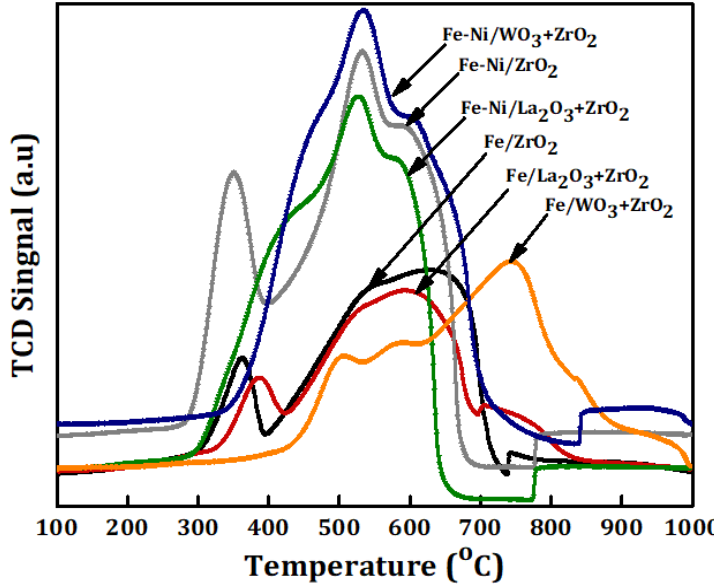
Figure 3. Temperature-programmed reduction (TPR) profiles of the Fe and Fe-Ni catalysts supported on different carriers.